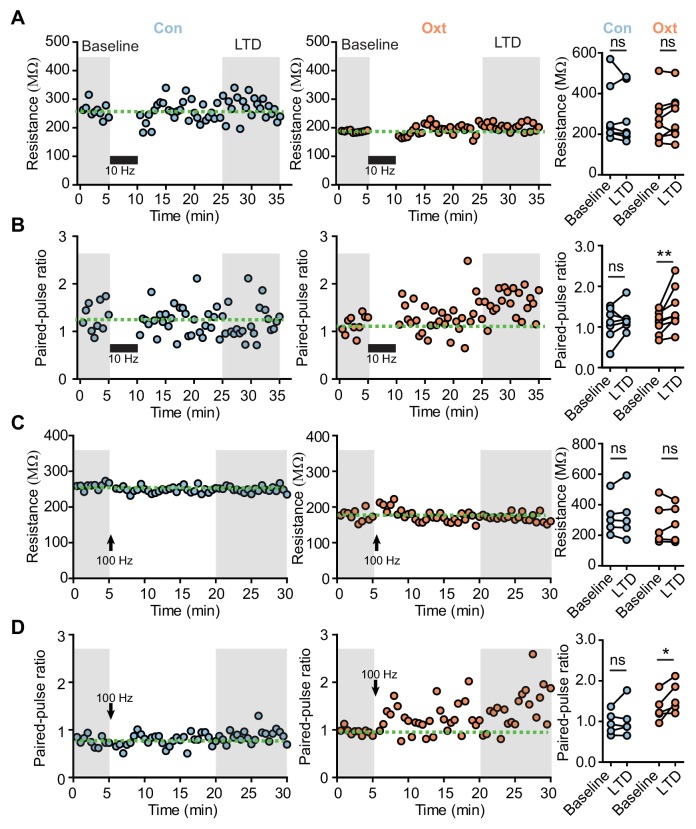
Oxytocin regulates presynaptic neurotransmitter release during LTD.(A) Left: input resistance measurements from one VTA DA neuron in the control condition during LTD induction. Black bar marks the 5 min period of 10 Hz electrical pulses that were used to induce LTD. Middle: same measurements in another cell in the presence of oxytocin. Right: summary of input resistance in the control condition and in the presence of oxytocin. Shaded regions indicate time windows used to calculate average input resistance for baseline and LTD. Wilcoxon matched-pairs signed rank test, n = 7 neurons from five mice for control, eight neurons from six mice in the presence of oxytocin. (B) Same as (A), but for PPR. **p<0.01, Wilcoxon matched-pairs signed rank test, n = 7 neurons from five mice for control condition, eight neurons from six mice in the presence of oxytocin. (C) Left: input resistance measurements from one VTA DA neuron in the control condition during LTD induction. Black arrow indicates 1 s of 100 Hz stimulation, repeated four times at 10 s intervals. Middle: same measurements in another cell in the presence of oxytocin. Right: summary data for input resistance in the control condition and in the presence of oxytocin. Shaded regions indicate time windows used to calculate average input resistance for baseline and LTD. Paired t-test, n = 5 neurons from five mice for control and oxytocin groups. (D) Same as (C), but for PPR. *p<0.05, Wilcoxon matched-pairs signed rank test, n = 5 neurons from five mice for control and oxytocin groups.